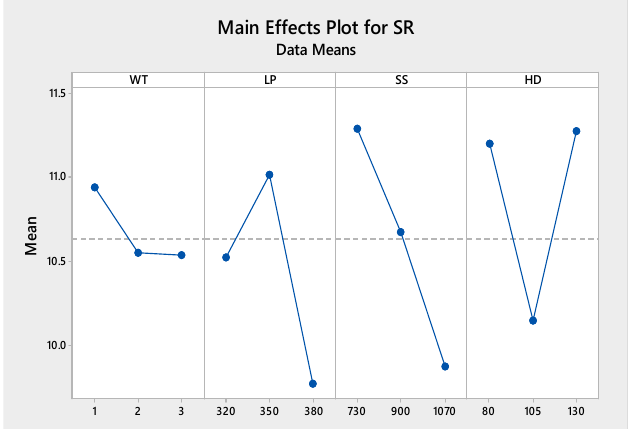
Figure 7. Main effects plot for SR.